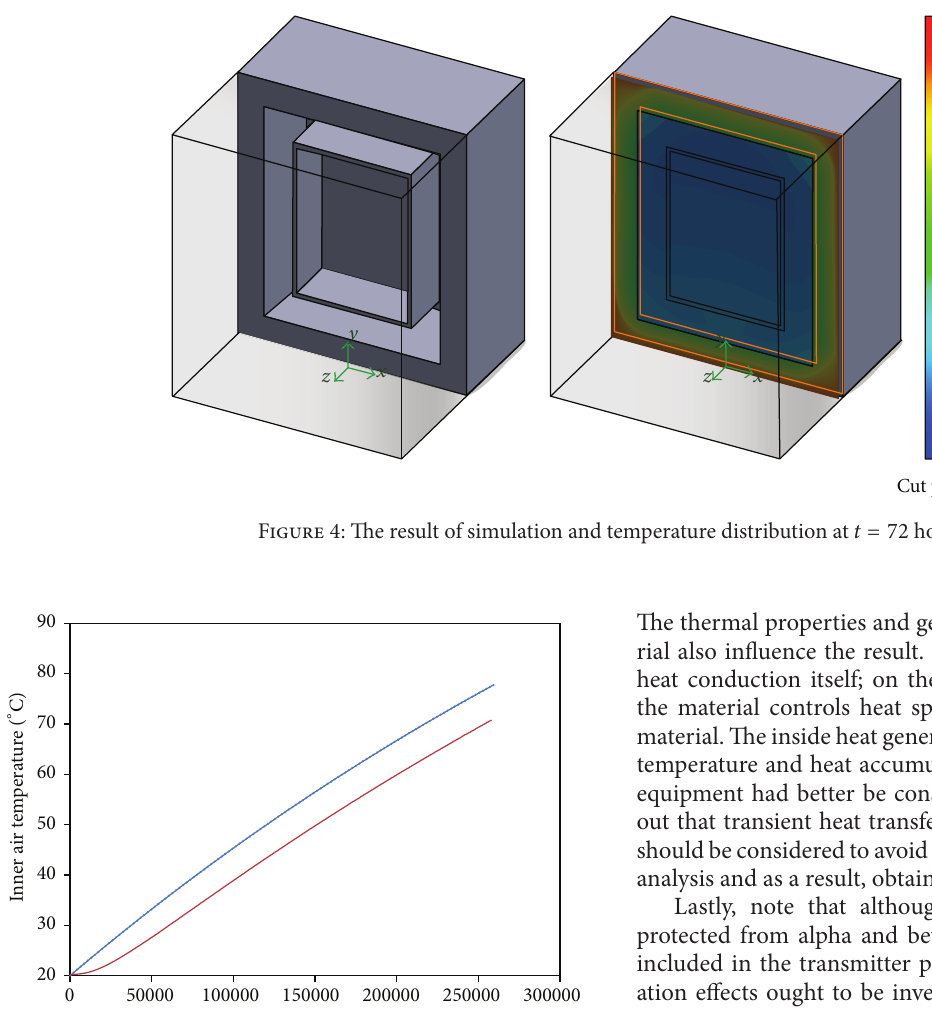
Figure 5: Temperature comparison of the results between equation- based and simulation-based calculations along